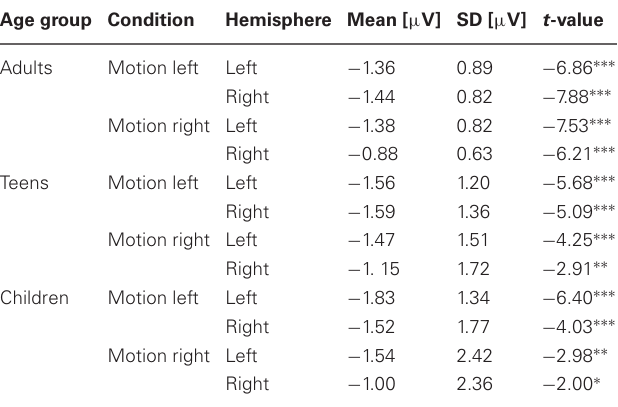
Table 2 | MMN (large deviant) for adults, teens, and children: amplitudes und significance.